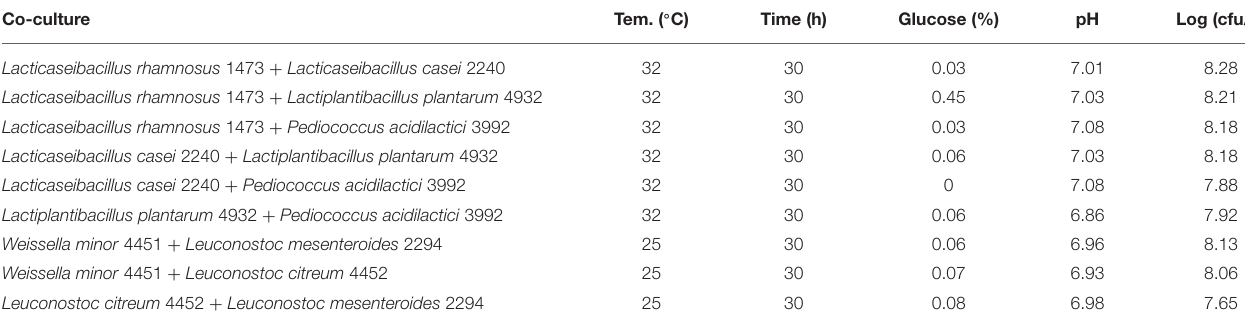
TABLE 3 | Experimental conditions of fermentations with co-cultures in samples without